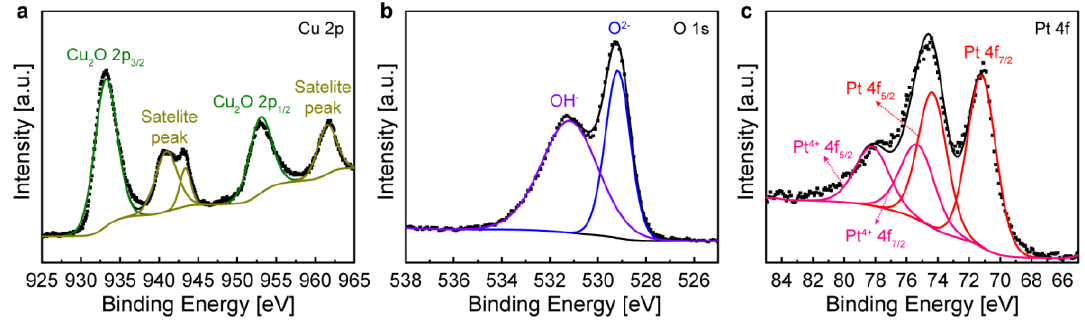
Figure 3. X-ray photoelectron spectra of Cu 2 O/Pt nanopattern. High-resolution elemental spectra of ( a ) Cu 2p, ( b ) O 1s, and ( c ) Pt 4f.